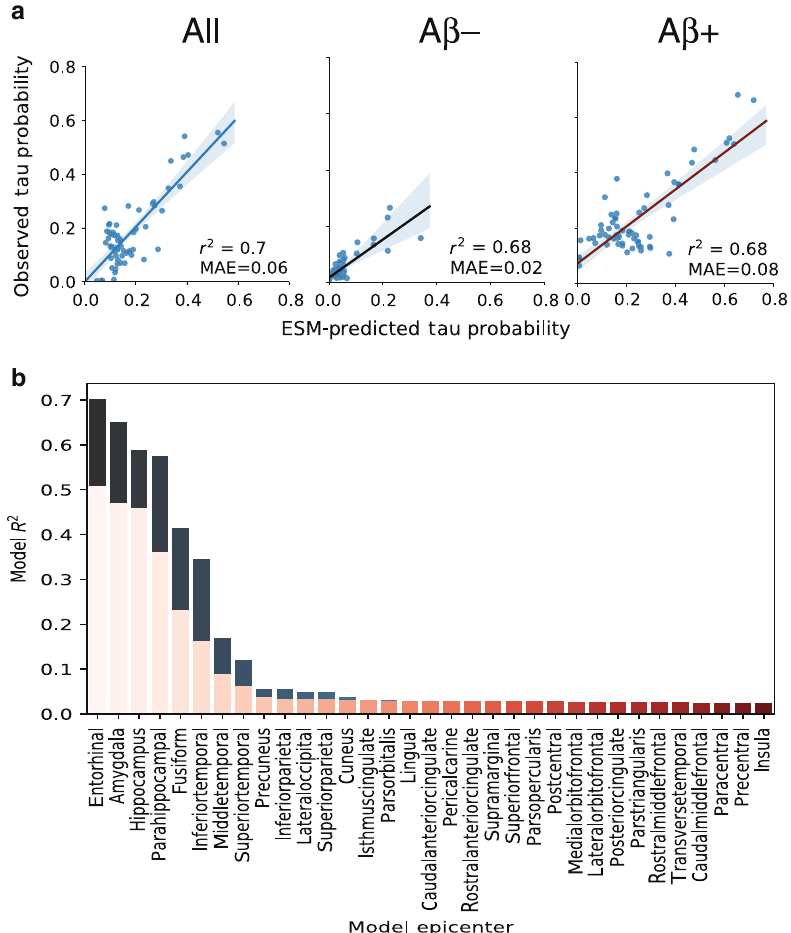
Fig. 3 Performance of ESM in predicting spatial progression of tau. a For each plot, each dot represents a region. The x -axis represents the mean simulated tau-positive probabilities across the population, while the y -axis represents the mean observed tau-positive probability. A value of (say) 0.3 for a given ROI would suggest that an average of 30% of all subjects included were predicted ( X ) or observed ( Y ) to have positive abnormal tau signal in that region. The average performance of the four different models are shown separately for (left) all subjects, (center) A β − individuals and (right) A β + individuals. b The ESM was rerun using each left – right pair of ROIs as the model epicenter. The model fi t ( r 2 ) is depicted on the y -axis, and each bar represents the fi t of a model using a given region as model epicenter. Blue bars represents global model fi t across all subjects, and red bars represent the mean within-subject model fi t. An entorhinal cortex epicenter provided the best model fi